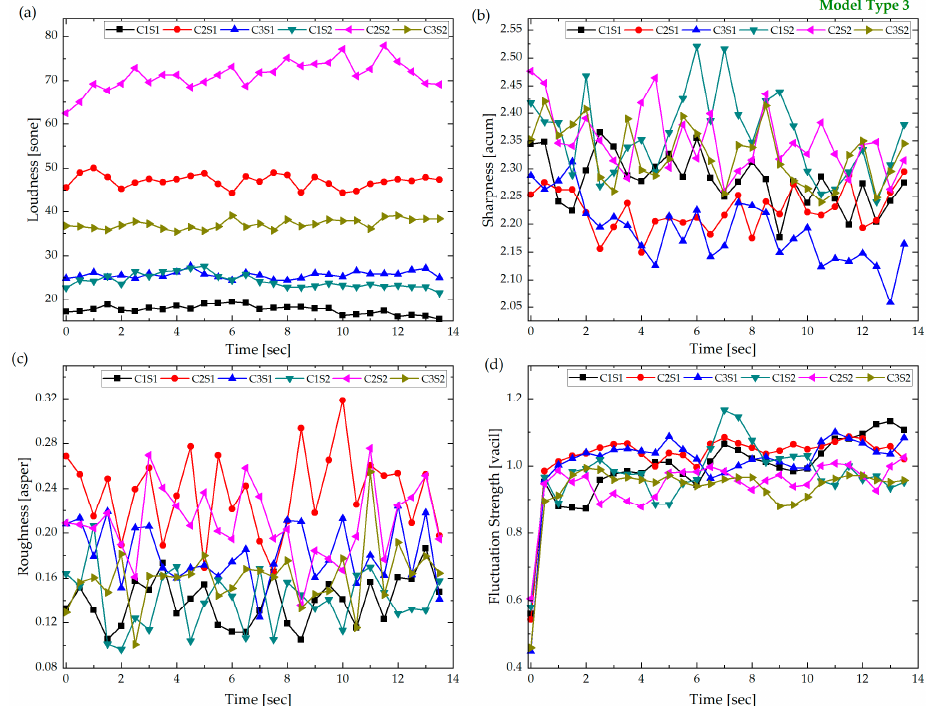
Figure 5. Psychoacoustic parametric values for the vacuum cleaner (model type 3). ( a ) Loudness, ( b ) sharpness, ( c ) roughness, and ( d ) fluctuation strength.